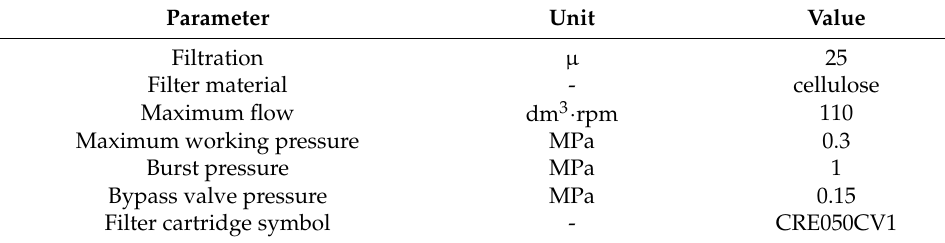
Table 8. Technical parameters of the filter SOFIMA RFM 040 (F 1 , F 2 ).